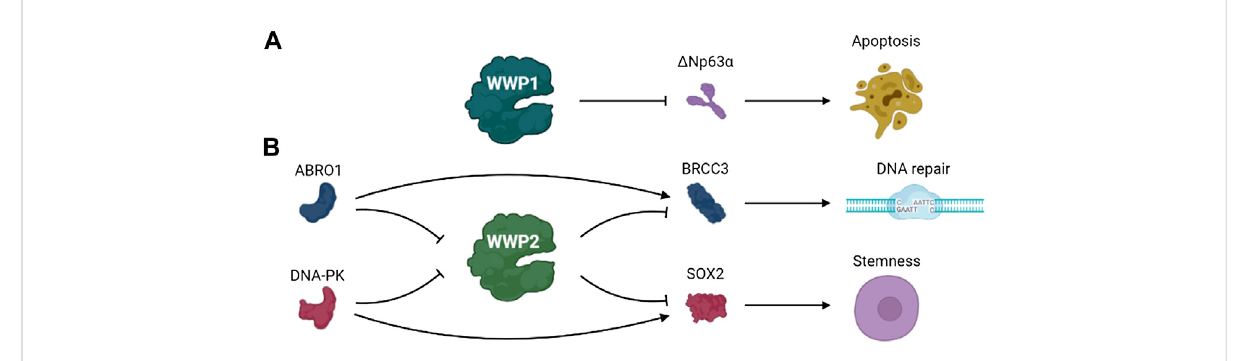
FIGURE 5 The pathways involved in DDR of (A) WWP1 and (B)